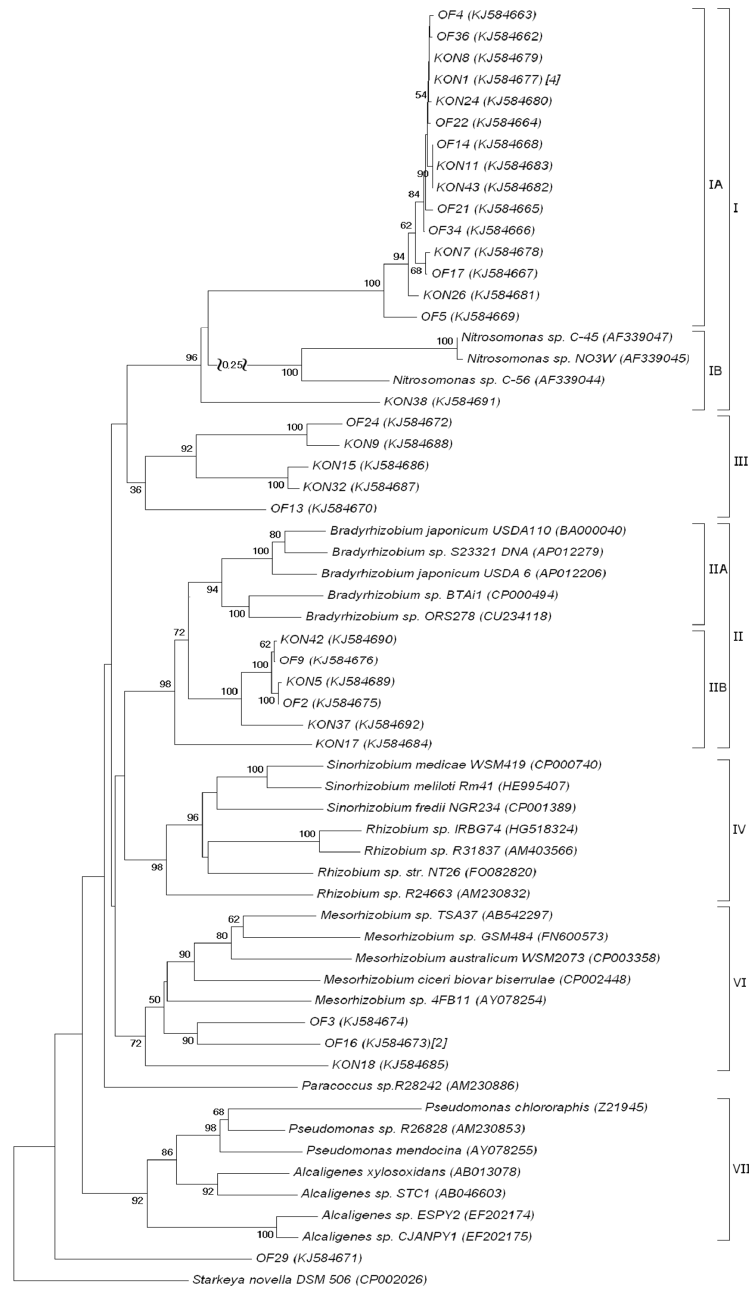
Figure 7. Phylogenetic analysis of the nirK gene sequence obtained from activated sludge samples from the technical scale. The rooted phylogenetic tree was built on the basis of 60 sequences (31 test clones and 29 sequences obtained from the Gene Bank), using the algorithm of combining neighboring taxa. The figure shows the bootstrap values above 50% for 500 repetitions. In parentheses () the accession numbers from the Gene Bank are shown, in square brackets [] the number of repetitions of the same sequence within the analyzed maple library.